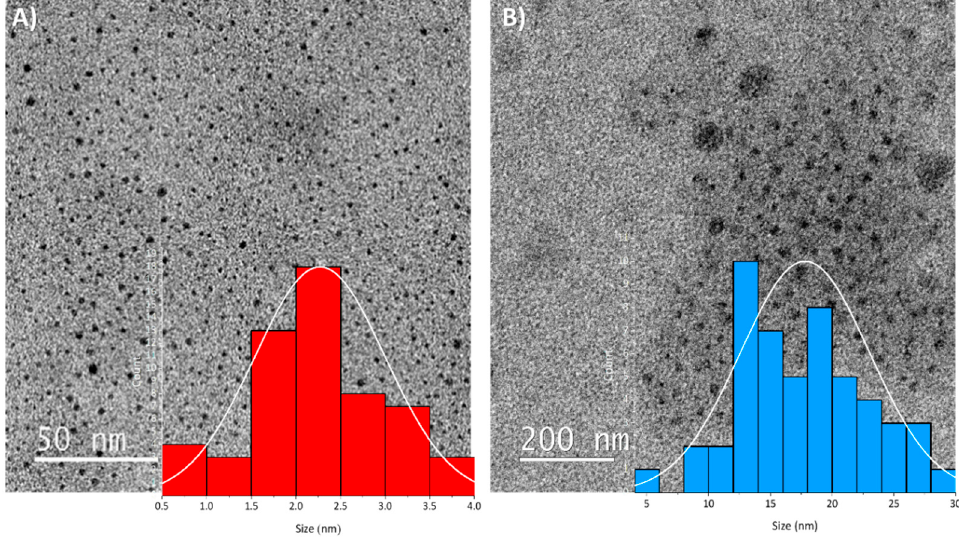
Figure 1. TEM images for ( A ) Hg-NPs Route A and ( B ) Hg-NPs Route B . Inset histograms related. A ζ value of +51.7 mV was obtained for Hg-NPs Route A and +13.2 mV for Hg-NPs Route B .